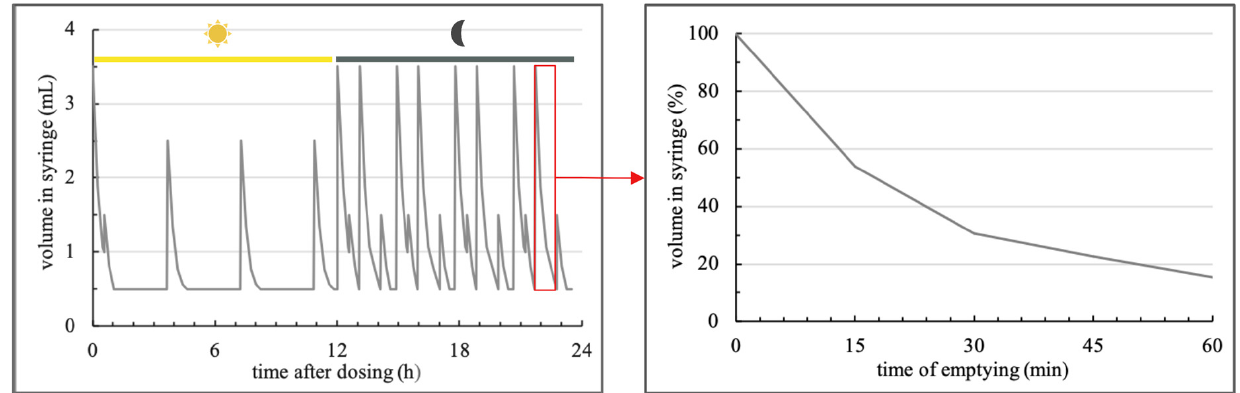
Figure 7. Volume pattern with marked photo and scotophase ( left ) and one hour kinetics of emptying derived from in vivo data [16,20–22] ( right ).